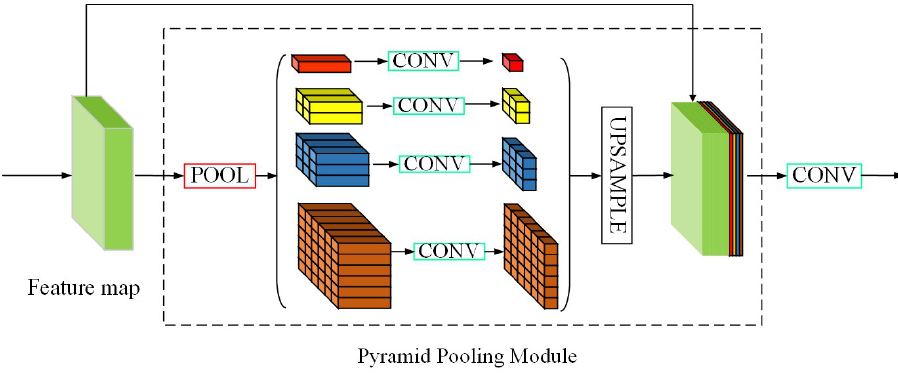
Figure 4. Structure of the feature extraction network (ResNet50).